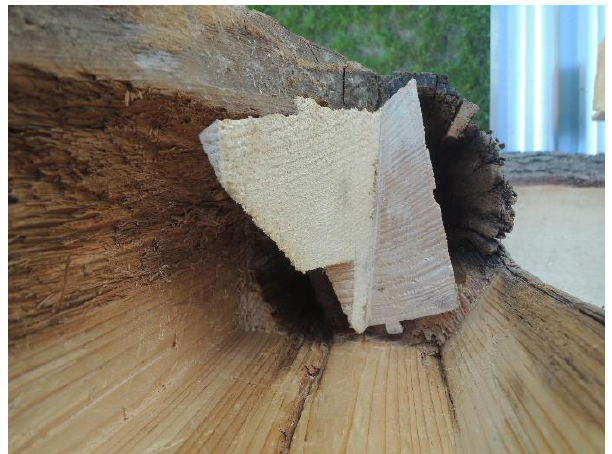
Figure 18. The rear insert fixed in the grooves.